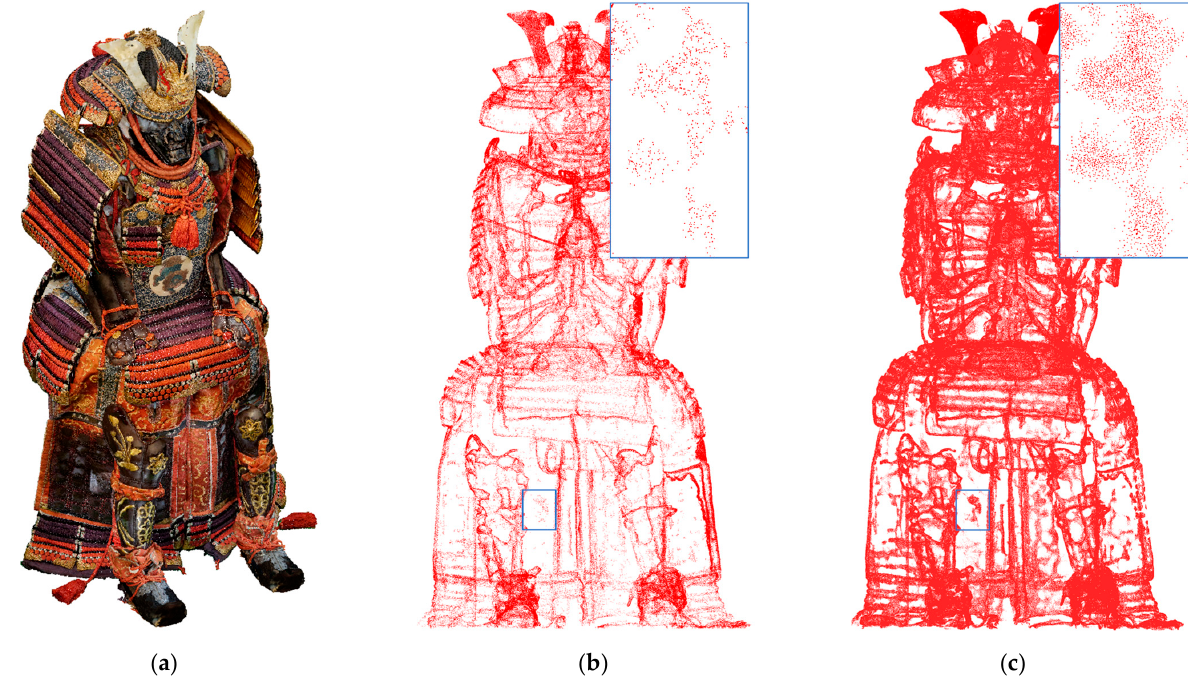
Figure 20. Upsampling experiment for 3D-scanned data with soft edges. The scanned target is the Japanese armor. Image ( a ) shows the 3D-scanned point cloud (9,094,466 points) acquired by our photogrammetric 3D scanning. Image ( b ) shows the extracted edge points (2,571,474 points) by adopting change-of-curvature and the type (c) function with f th = 0.03, F th = 0.2, α min = 0.2, α max = 1.0, and d = 2.0. Image ( c ) shows the soft-edge points increased by our upsampling network (10,285,896 points).